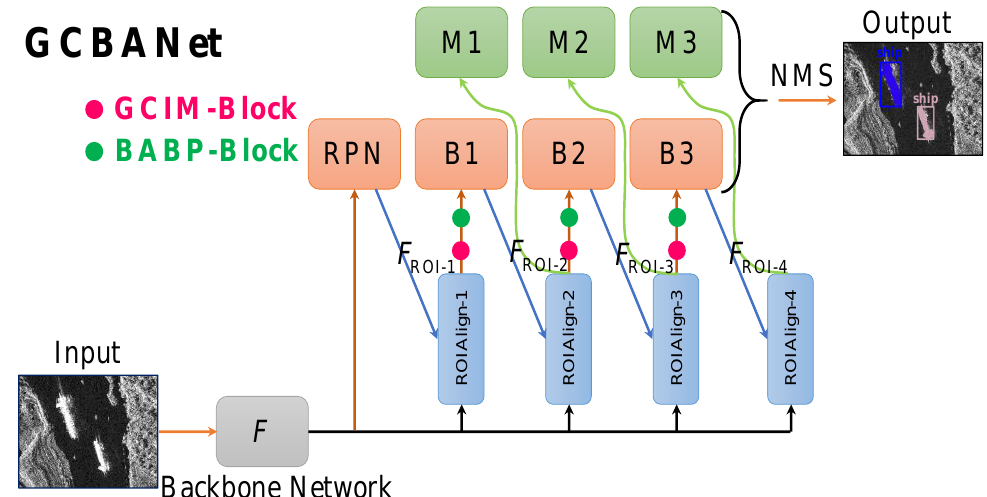
Figure 1. The architecture of the global context boundary-aware network (GCBANet). F denotes the feature maps of the backbone network. RPN denotes the region proposal network. FROI- i denotes the pooled ROI features in the i -th stage. B i denotes the box prediction in the i -th stage. M i denotes the mask prediction in the i -th stage. GCBANet adopts a cascade structure which sets three stages to refine box and mask prediction. GCIM-Block denotes the global context modeling block. BABP-Block denotes the boundary-aware box prediction block. NMS denotes non-maximum suppression .